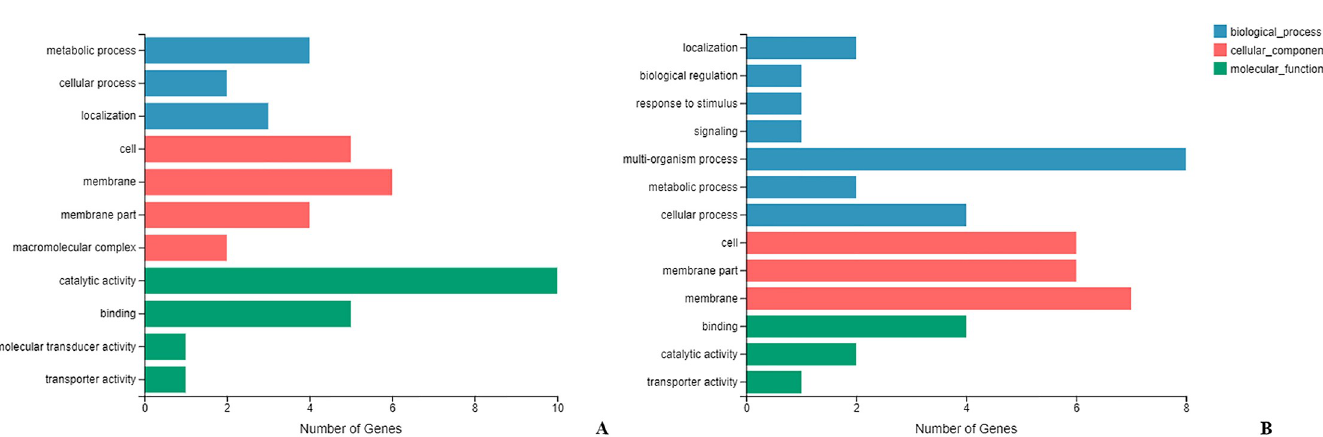
Fig 3. GO annotation of differentially expressed genes assigned to three GO categories. (A) shows the categories of upregulated genes, (B) shows the categories of downregulated genes. Blue color indicated the biological process function, including metabolic process, localization, biological regulation, response to stimulus, signaling, multi-organism process, cellular process; red color indicated the cellular component function, including macromolecular complex, cell, membrane part, membrane; green color indicated molecular function, including binding, catalytic activity, transporter activity, molecular transducer activity.